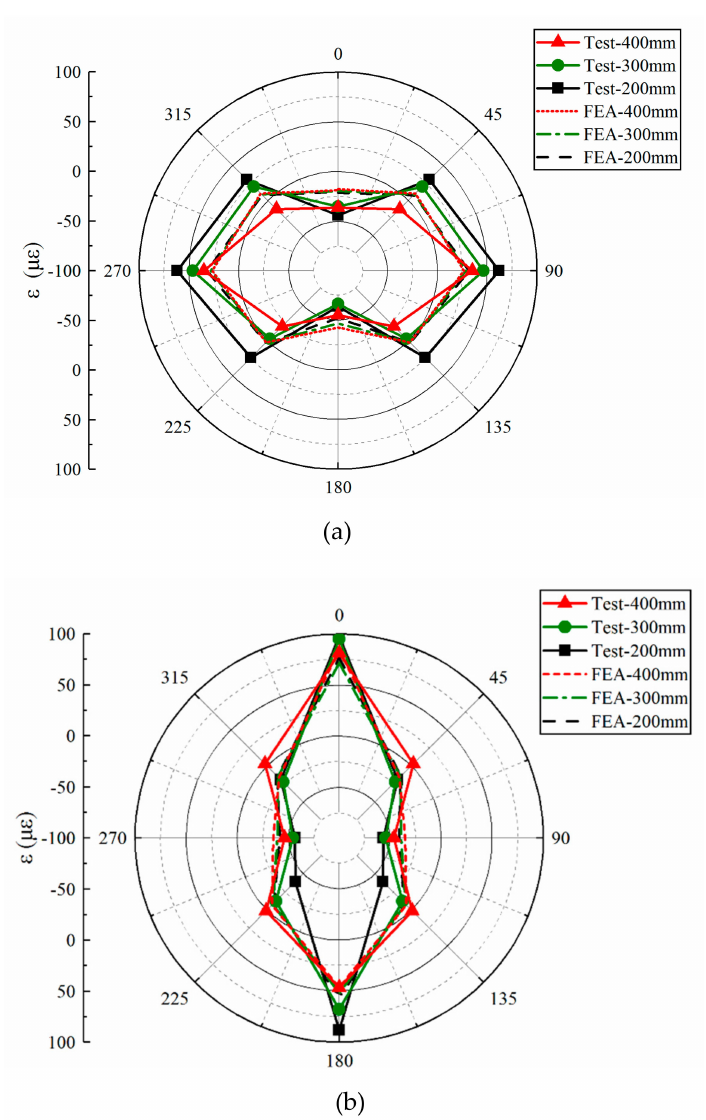
Figure 17. Circumferential strain curve of the pipes containing cracks with di ff erent lengths: ( a ) outer wall and ( b ) inner wall.